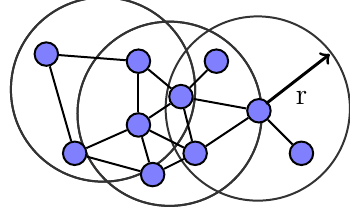
Figure 1. Modelling the topology of an ad-hoc